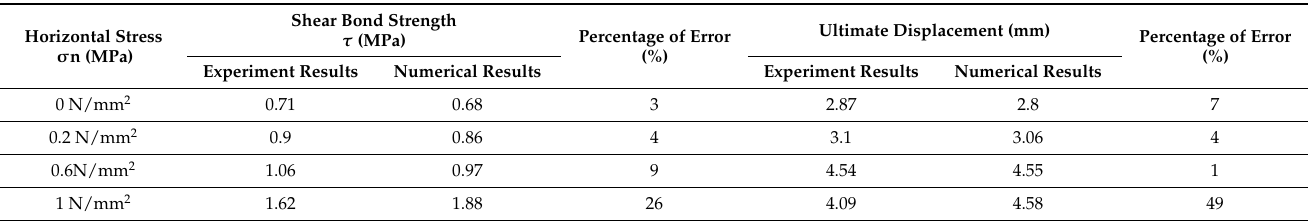
Table 8. Comparison between numerical results and experiment data for unreinforced shear triplet prisms.